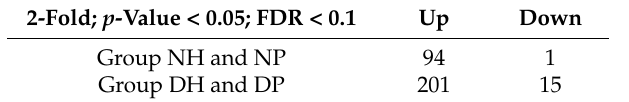
Table 1. The number of differentially expressed genes (DEGs) in each combination. 2-Fold; p -Value < 0.05; FDR < 0.1 Up Down Group NH and NP 94 1 Group DH and DP 201 15